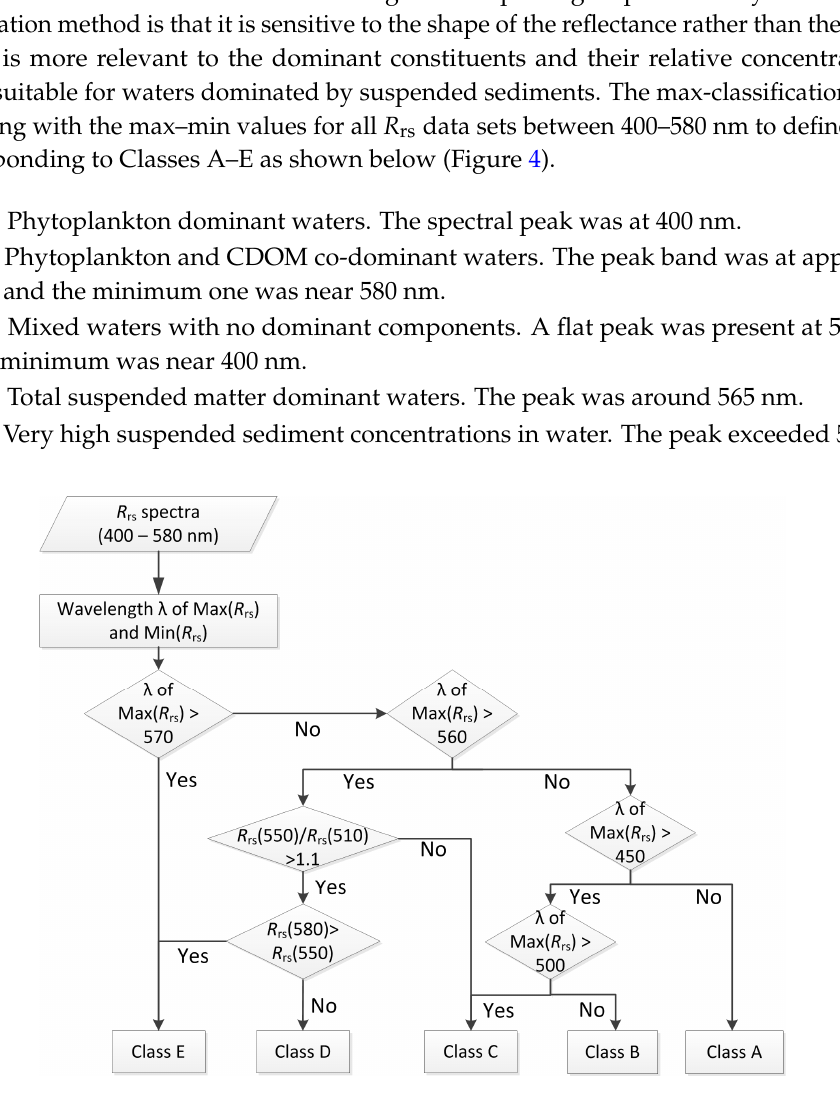
Figure 4. The flowchart for the maximum–minimum values for supervised classification (referred to in shortened form as the max-classification) of R rs spectra. Min( R rs ) was used only to assist with the confirmation of each class; the minimums of Classes A and B were at 580 nm and Classes C and D were near 400 nm.